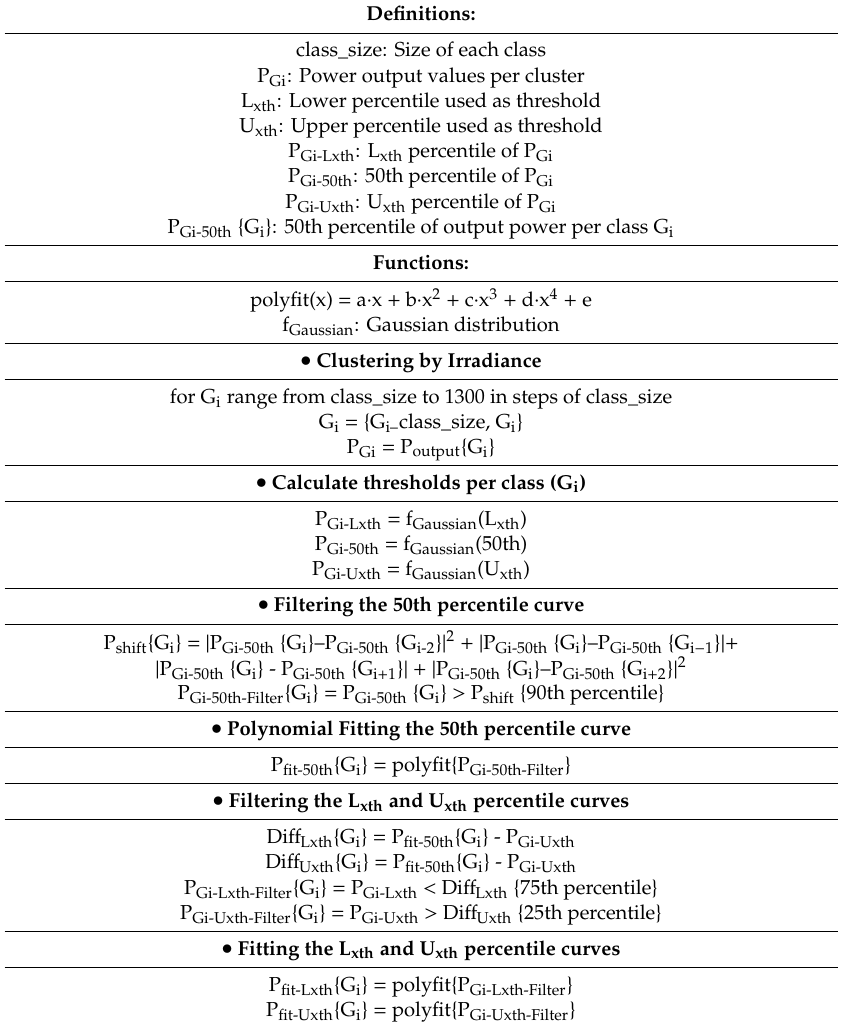
Table 1. Algorithm for data filtering